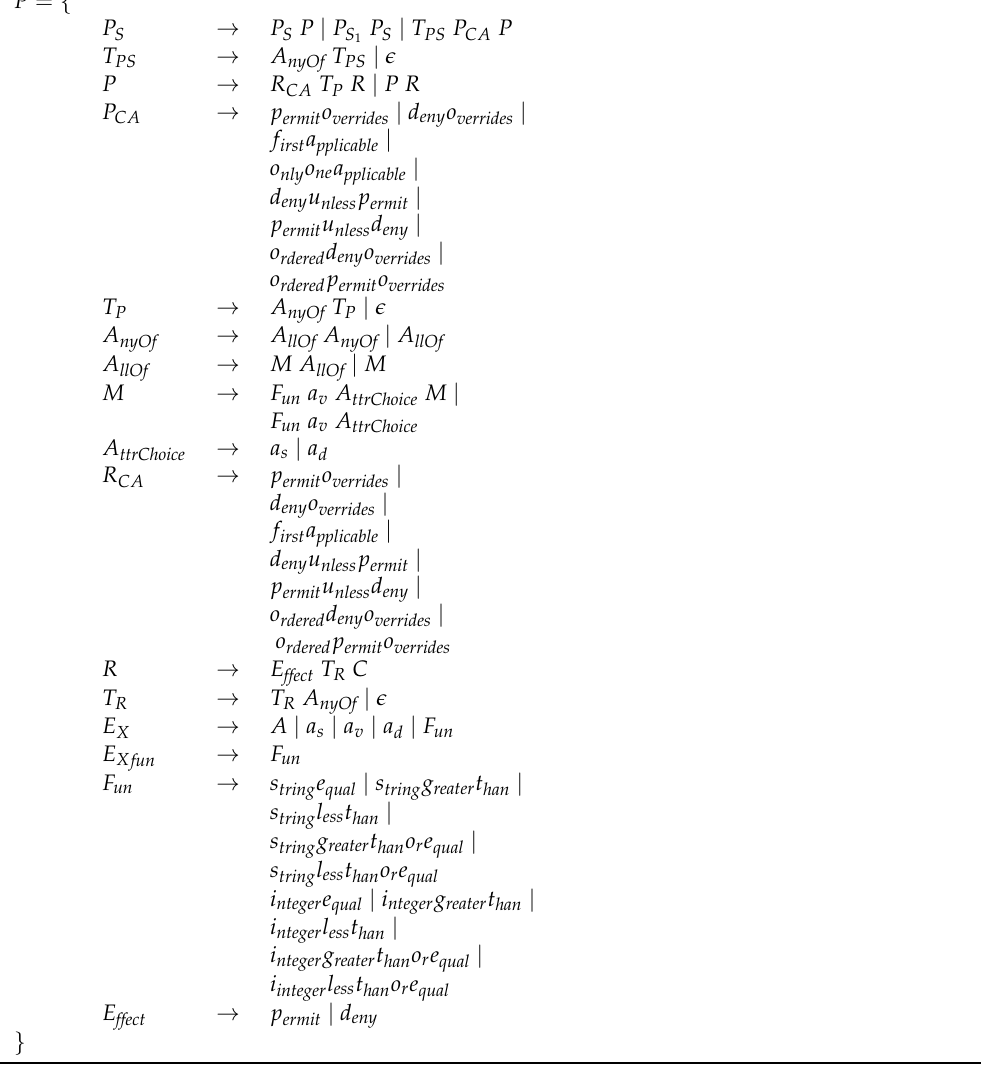
Table 4. Productions of XACML 3.0